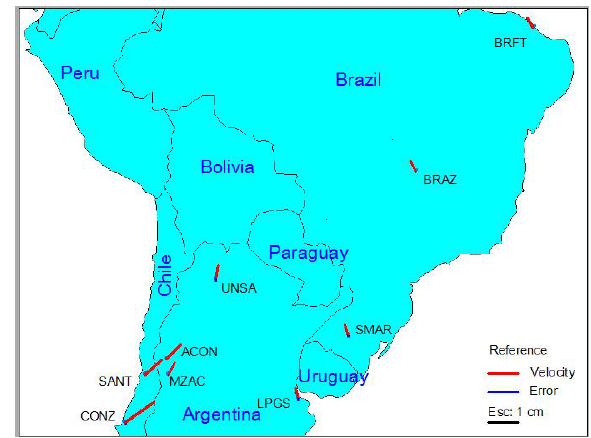
Figure 3. a- Time serie data from the Acon GPS permanent station, b - Displacement vectors Fig. 3. (a) Time serie data from the Acon GPS permanent station, (b) Displacement vectors. Figure 4. Helmert Transformation